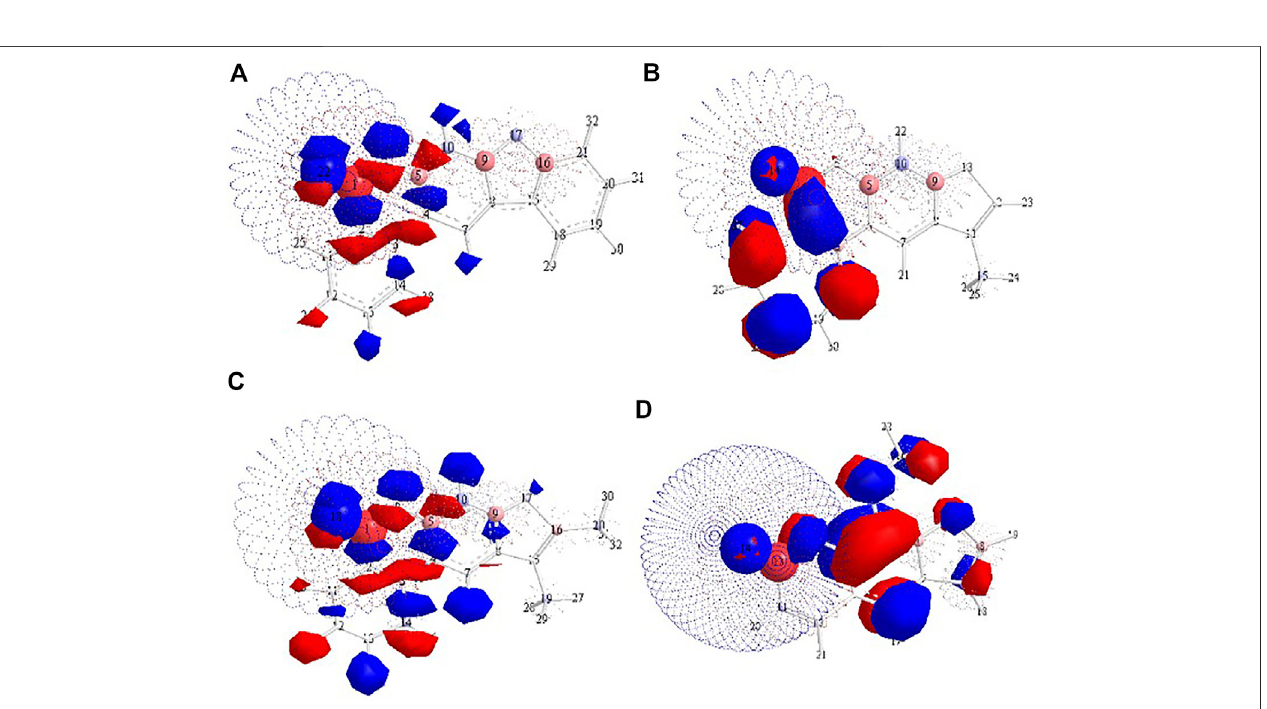
FIGURE 3 | The structure of furocoumarins: A — KC3; B — KC4; C — KC5; D — 8-MOP. The color corresponds to a partial charge. Atoms carrying a partial positive charge are colored red, and the negative charge is blue. Dimensions re fl ect the amount of charge. The dotted lines in the fi gures show the surfaces, the radius of which corresponds to the magnitude of the charge. The data are given for state S 0 .